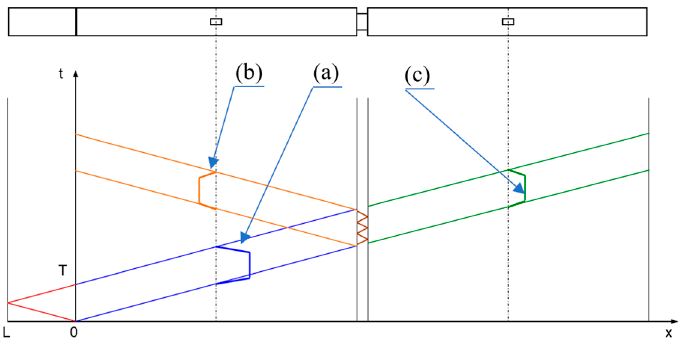
Figure 3. Signals recorded during SHPB tests: ( a ) incident impulse; ( b ) reflected impulse; ( c ) trans- mitted impulse.